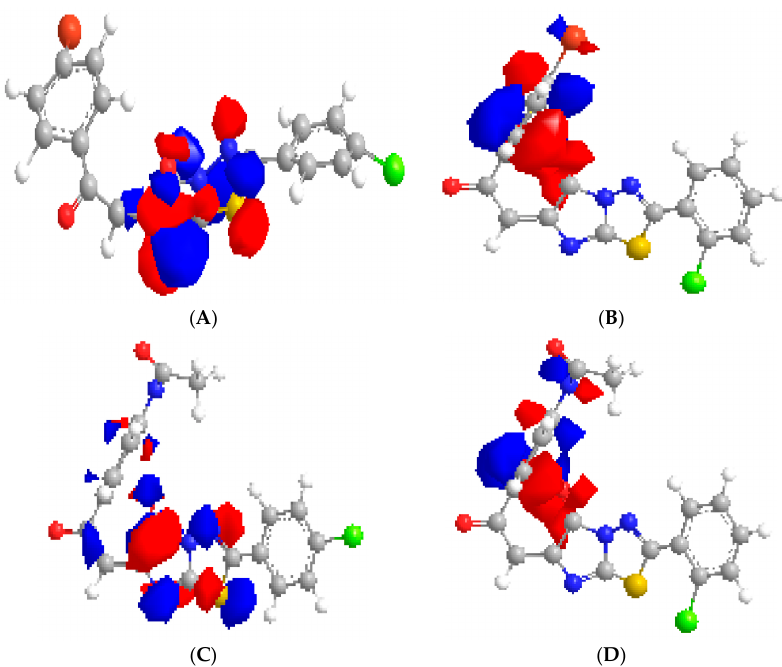
Figure 1. Outlines the electron distribution in HOMO for 4e ( A ); 4f ( B ); 4b ( C ) and 4c ( D ) compounds, respectively, are outlined, confirming that electron density is low among the o-chloro derivatives (decreased HOMO and increased activity). Electron deficient at the center of molecule means increase the antibacterial activity as the compounds 4f ( B ) and 4c ( D ).